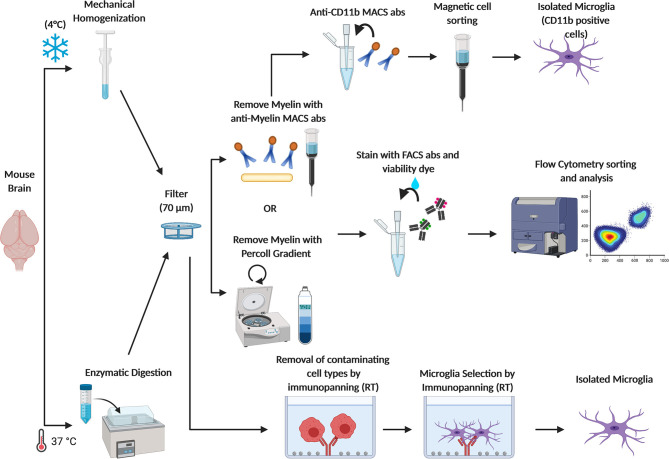
Schematic figure depicting current methods adopted to obtain freshly isolated microglia. Brains from adult mice are (1) homogenized with a dounce homogenizer at 4°C to avoid microglia activation or (2) enzymatically digested at 37°C in the water bath, and filtered through a 70 μm cell strainer. Myelin is removed either by centrifugation with a Percoll gradient or by using anti-myelin magnetic cell sorting (MACS) antibodies. Then, microglia are sorted from other CNS cell types by FACS through specific cell markers. Otherwise, microglia are isolated by MACS anti-CD11b antibodies. Microglia can also be isolated by immunopanning. In this approach, the cells suspension is passed over a series of antibody coated dishes in order to remove contaminating cell types. Then, microglia are positively isolated in the last coated dish.